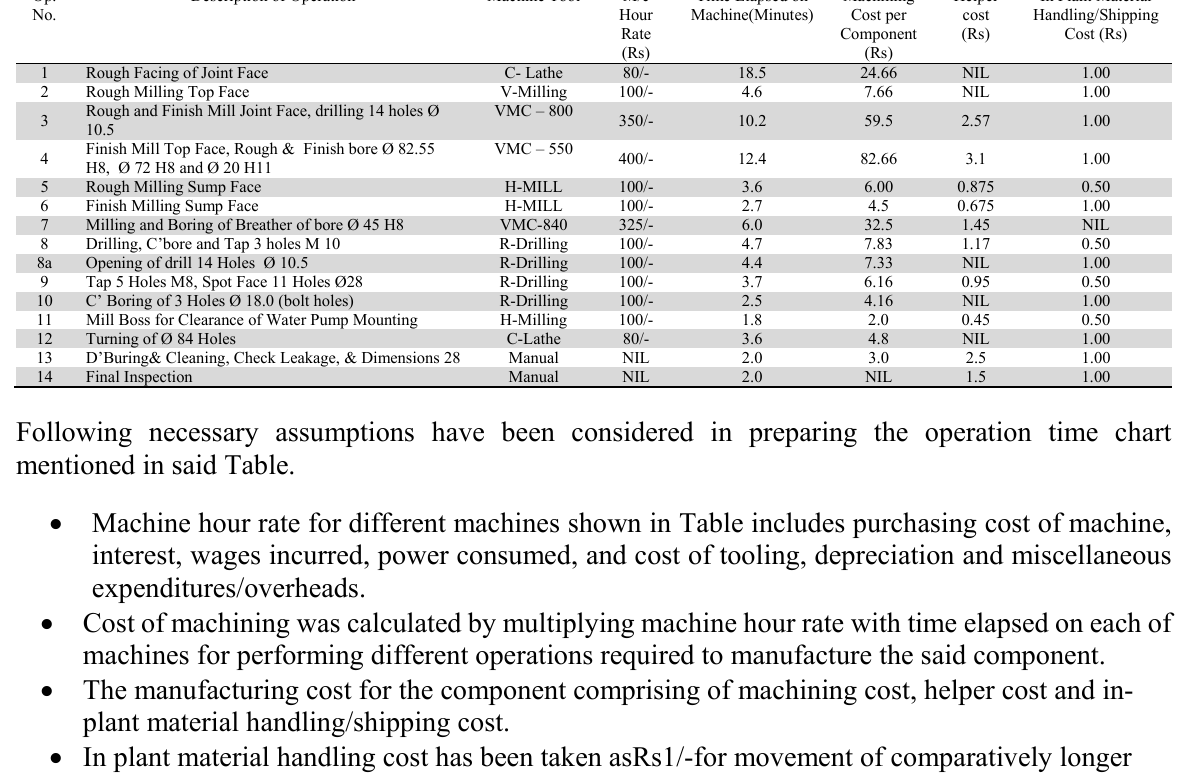
Operation time chart for timing gearbox cover using the existing process Op.